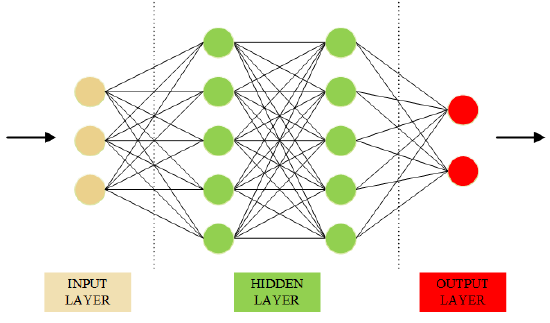
Figure 4. The structure of